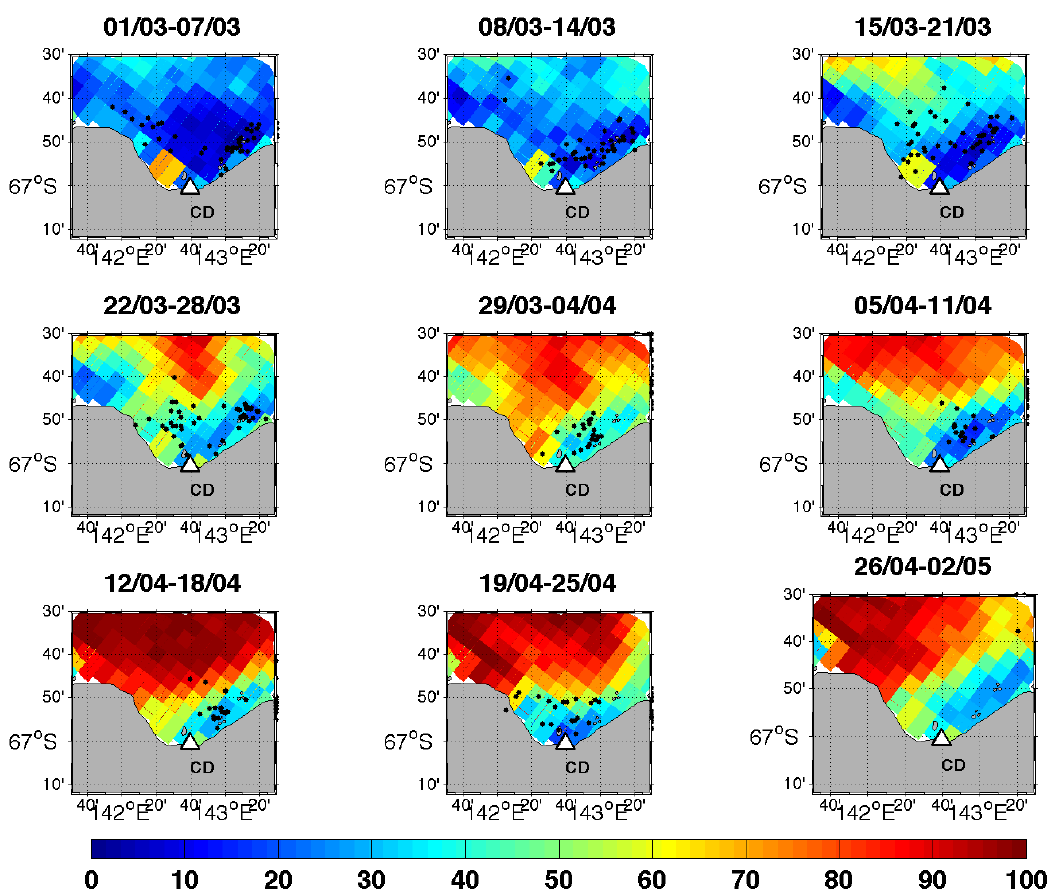
Fig. 5. Weekly locations of IMOS seals I1 and I2 (black dots) within Commonwealth Bay with mean sea ice concentration from AMSR-E (AMSR-E, 2008) from March through April 2010. Location of Cape Denison (CD) Automatic Weather Station as indicated by the